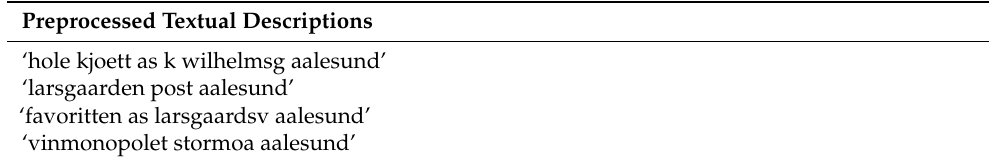
Table 3. Examples of preprocessed textual descriptions from transaction